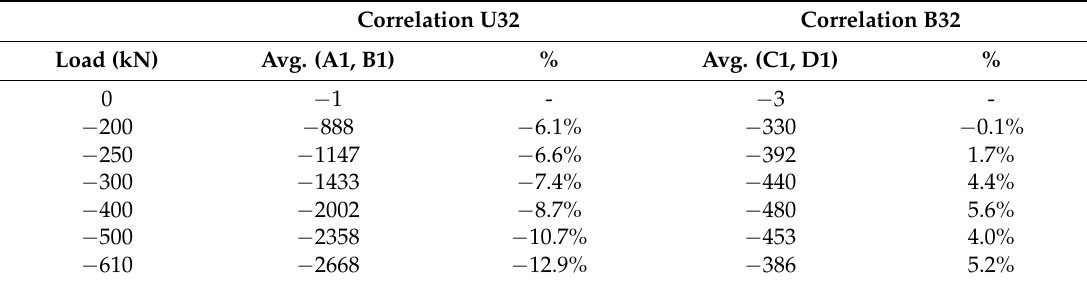
Table 5. Failure Load Correlation.